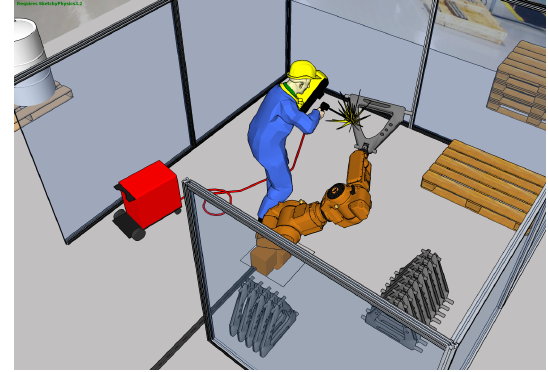
Figure 1: A collaboration between a human and a robot on a welding